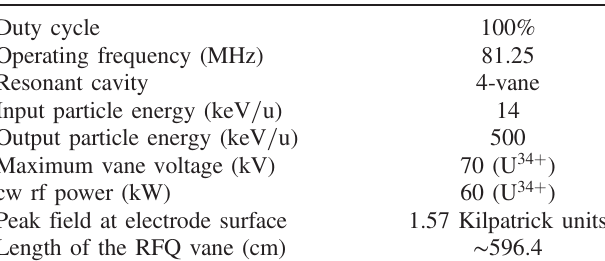
TABLE I. Basic design specifications of LEAF-RFQ.